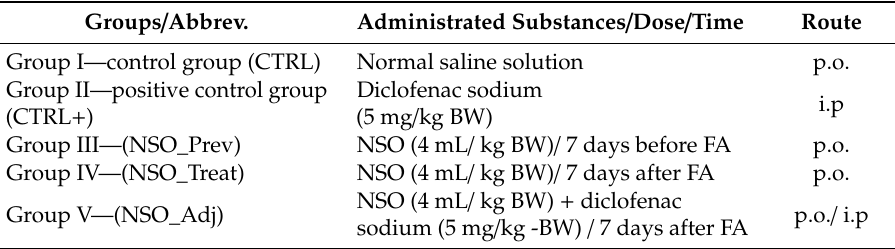
Table 2. Experimental design of Freund’s adjuvant-induced sub-acute inflammation. Groups / Abbrev. Administrated Substances / Dose / Time Route Normal saline solution